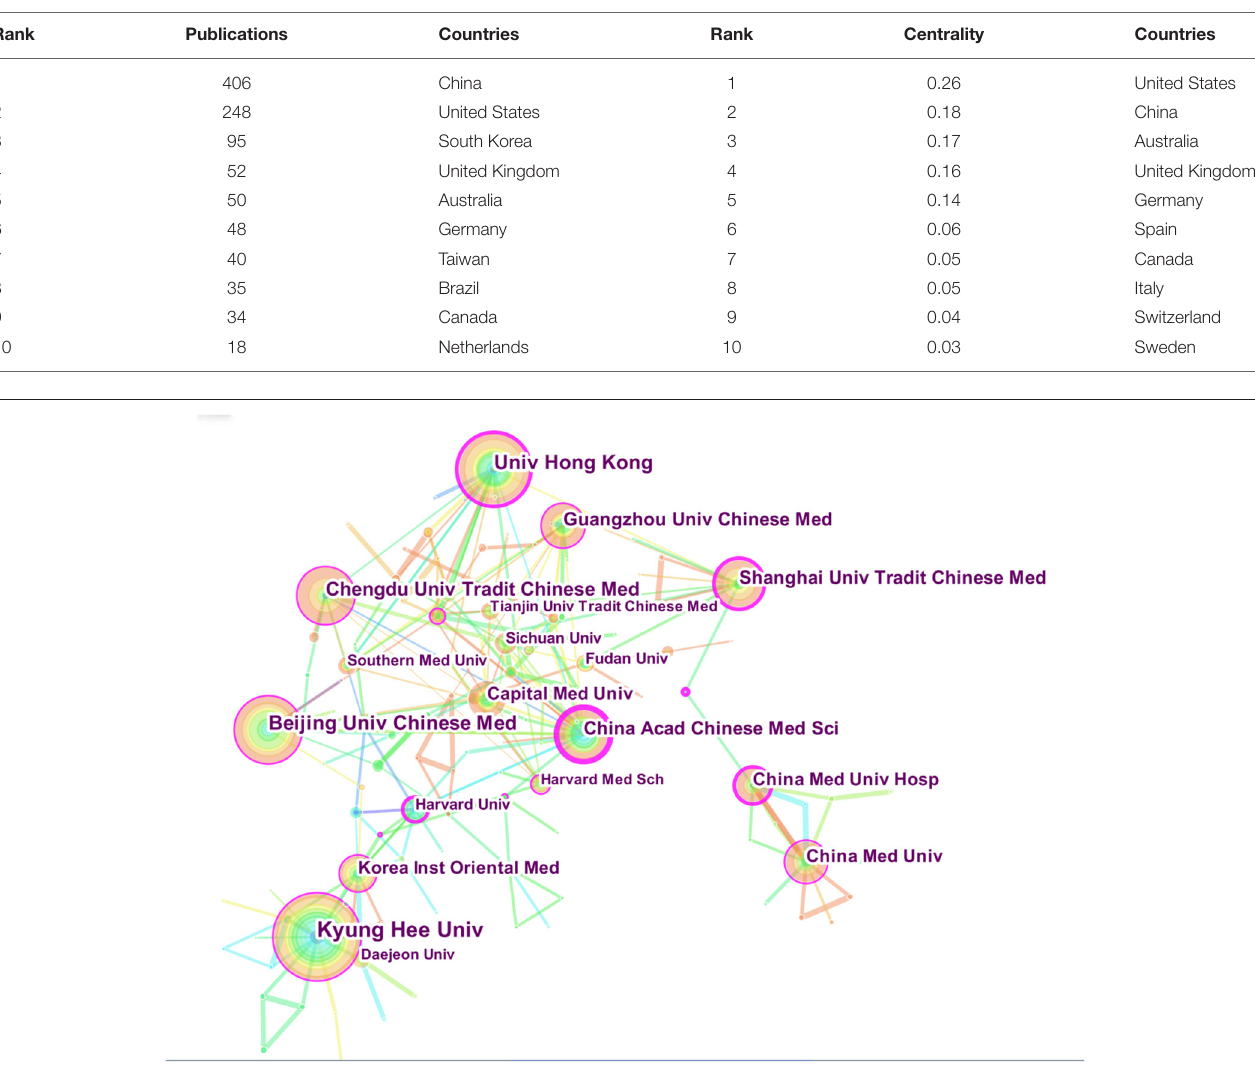
TABLE 3 | Top 10 publications and centrality of countries related to acupuncture on depression.